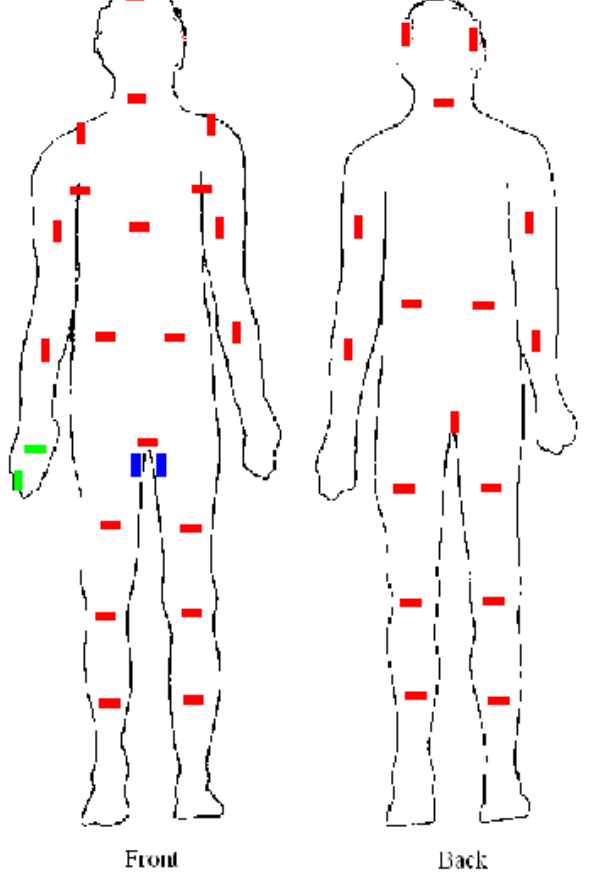
Figure 2. Sampling positions on